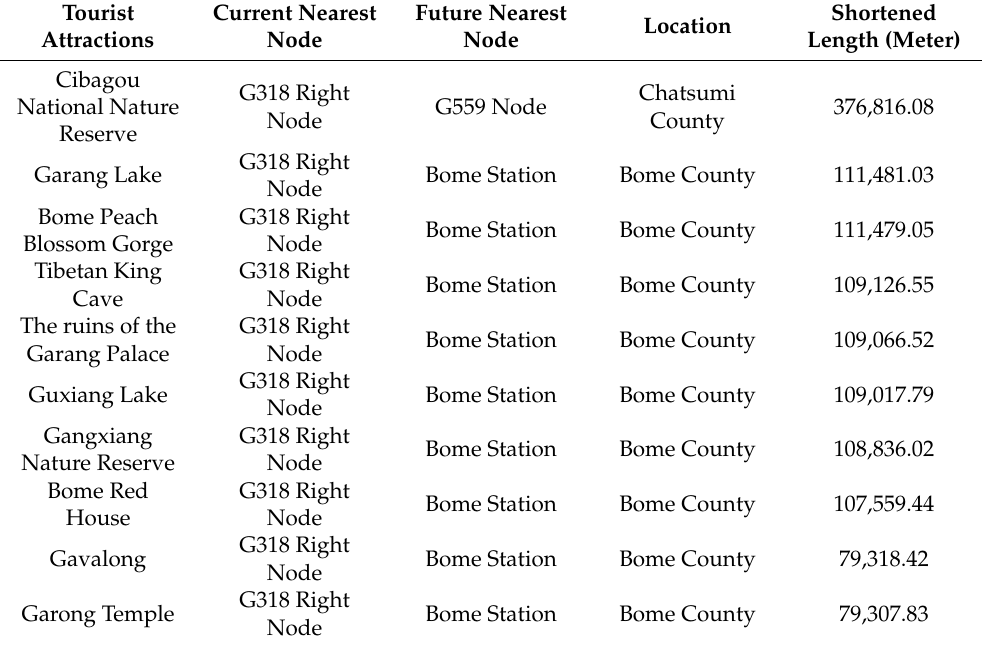
Table 8. The top 10 tourist attractions’ route length reduction above 50km from traffic nodes.